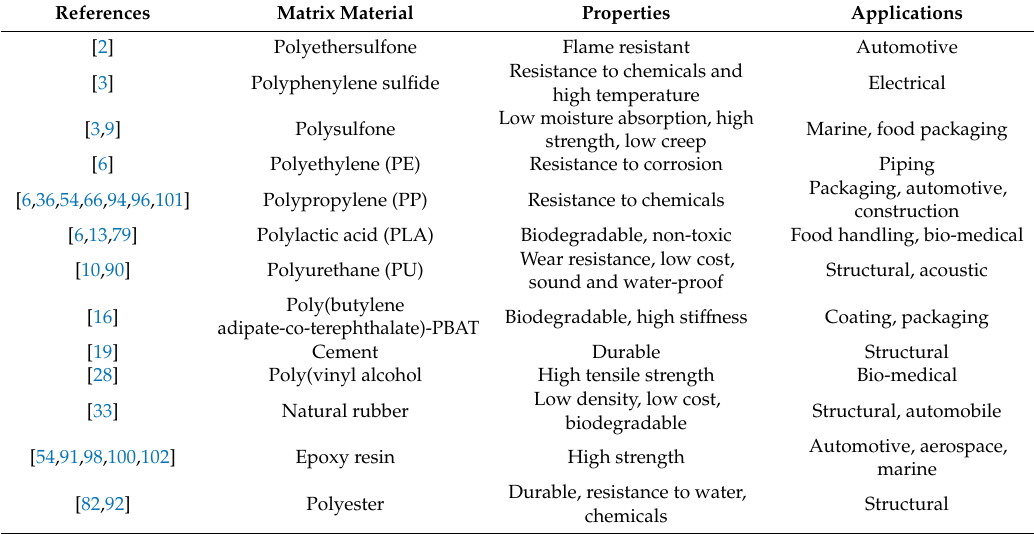
Table 3. Variety of available matrix